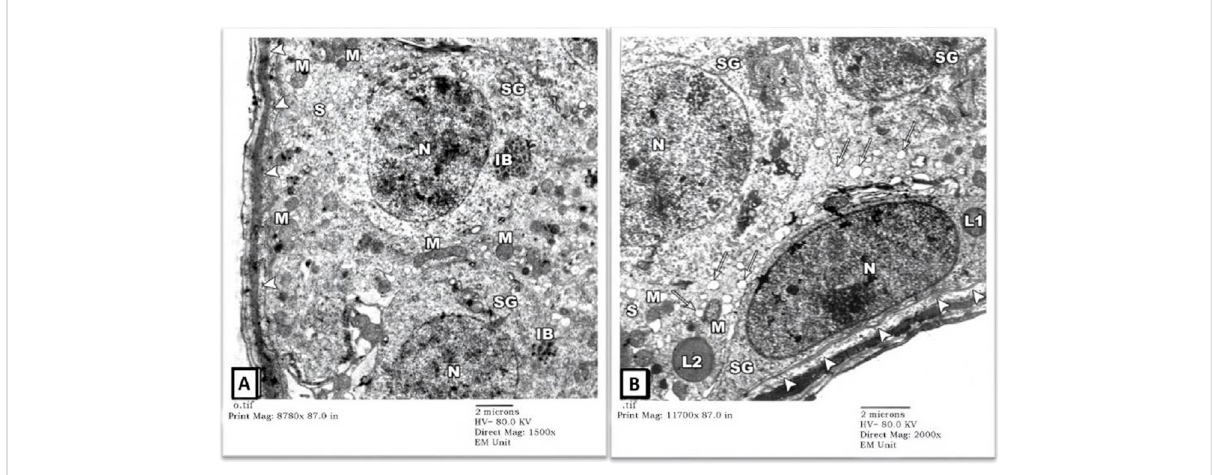
FIGURE 5 An electron micrograph of the testis from a rat in the Gin-treated group showing: (A) a part of the seminiferous tubule exhibiting two spermatogonial (SG) and a part of Sertoli cell (S) resting on a basement membrane (arrowheads) and housing numerous mitochondria (M), and inclusion bodies (IB). All cells, more or less, simulate those of the control rats. (Uranyl acetate and lead citrate X 1500, Print Mag. X 8780). (B) a part of seminiferous tubule displaying a spermatogonium (SG) and part of Sertoli cell (S) resting on a thick basement membrane (arrowheads). The cytoplasm of the Sertoli cell shows mitochondria (M), lipid droplets (arrows), and lysosomes (L). These cells regained more or less the control architecture. (Uranyl acetate and lead citrate X 2000, Print Mag. X 11,700).